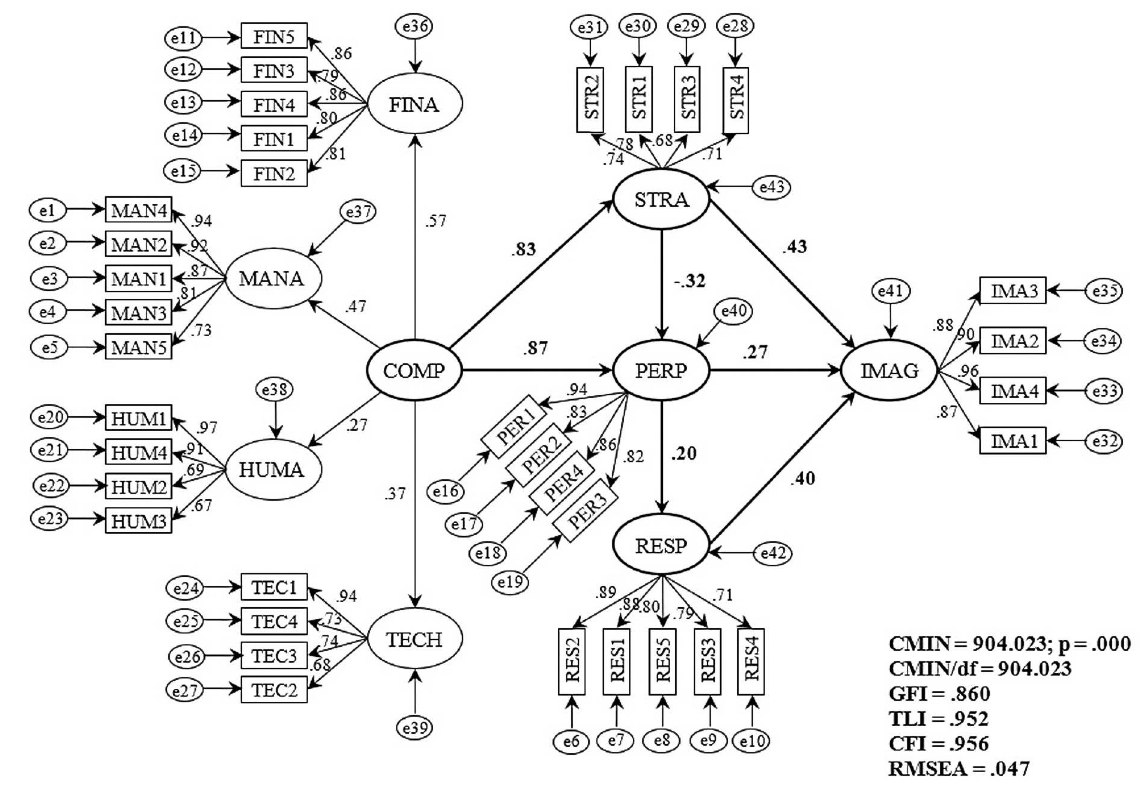
Figure 2. Standardized SEM model